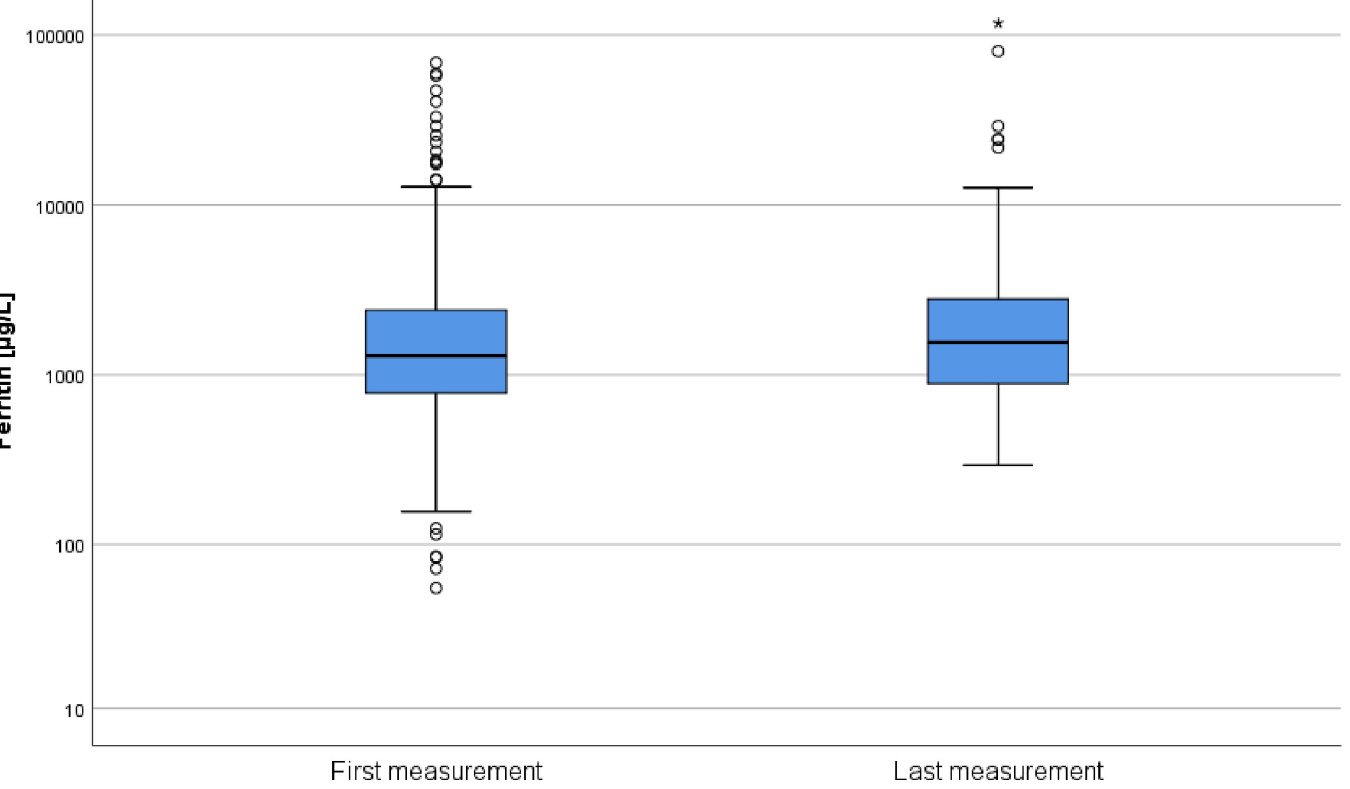
Fig 2. Distribution of ferritin values between first and last measurement. Median duration between two measurements was 36 (22–57) days. Boxplots show median with quartiles (25%, 75%). Whiskers below and above show minimum and maximum values, respectively. For visualization, y-axis is plotted in logarithmic